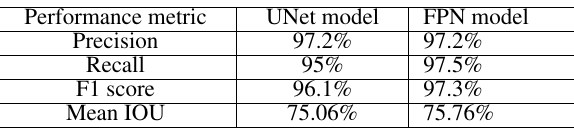
Table 2. Comparison of performance metrics of the best models of the UNet and the FPN on the test data from Florence all the separate predictions. This whole process is shown in Figure